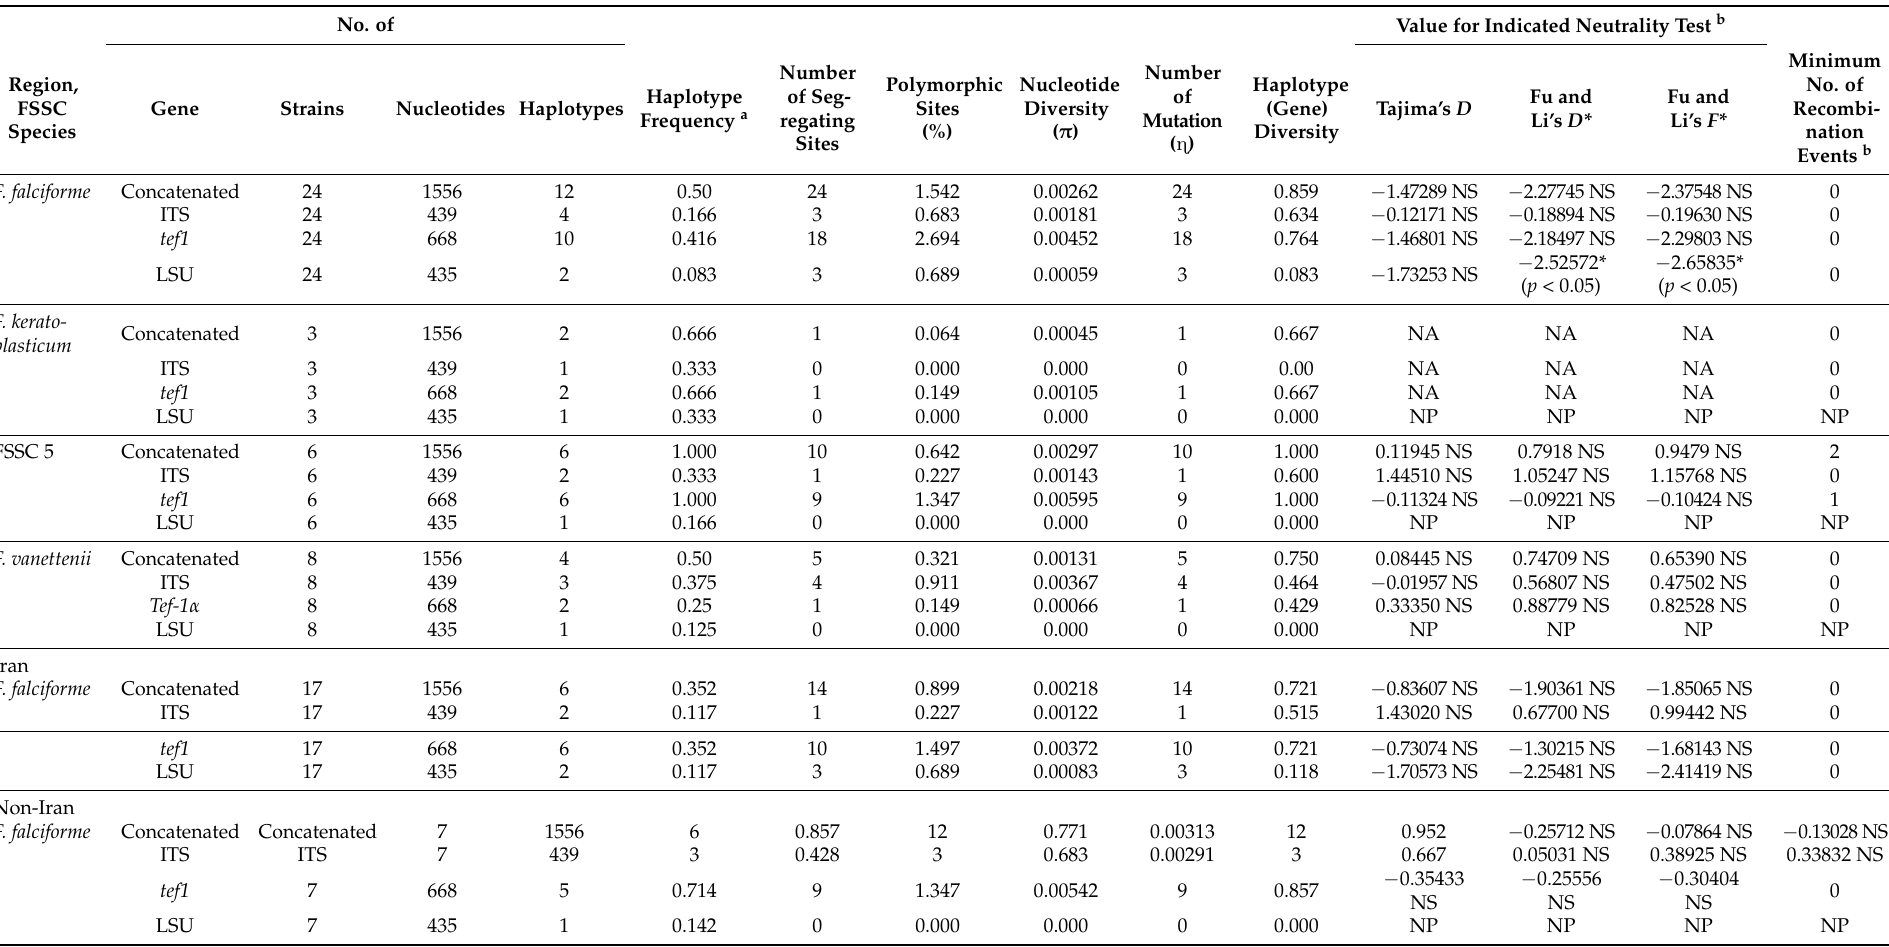
Table 3. Sequence variation statistics of the partial sequences of three gene regions (ITS, LSU, and tef1 ) among the FSSC isolates examined in this study. No.